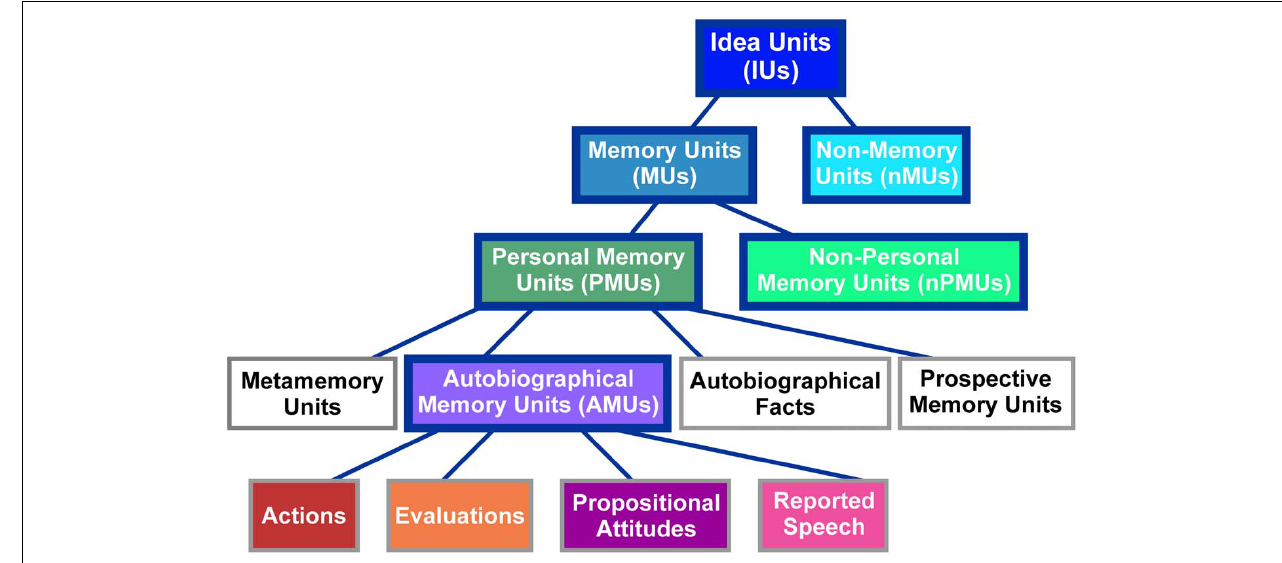
FIGURE 1 | Classification scheme of IUs employed in the present study. Figure modified from Dritschel (1991). The abbreviations of category names are specified in brackets. The same colors as used here in the